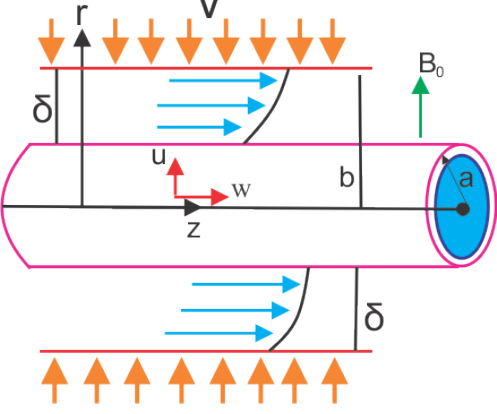
Figure 1. Geometry of the Physical